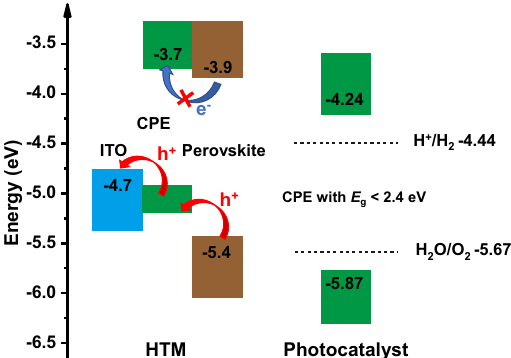
Fig. 7 Energy diagrams for HTMs and photocatalysts. Energy diagrams for the hole transport materials (HTMs, left) and the photocatalysts for water splitting (right). The energy windows for the conduction band (up) and the valence band (bottom) of CPEs are shown in green. The corresponding energy windows for ITO and the perovskite active layer are shown in blue and brown, respectively. The dash lines indicate the redox potentials of Table 2. Selected candidates for HTMs and water splitting photocatalysts. The values of HOMO, LUMO, reorganization energy ( λ ) and E g are displayed (all in eV). HTMs